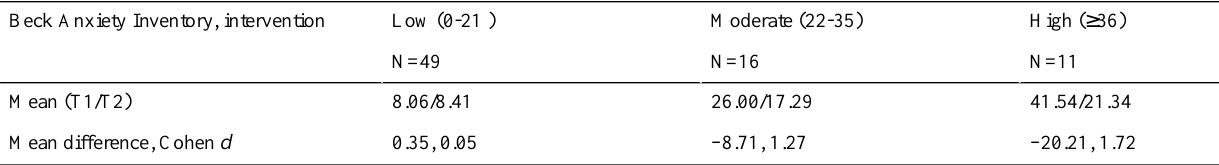
Table 9. Analysis of Beck Anxiety Inventory categories: intervention.